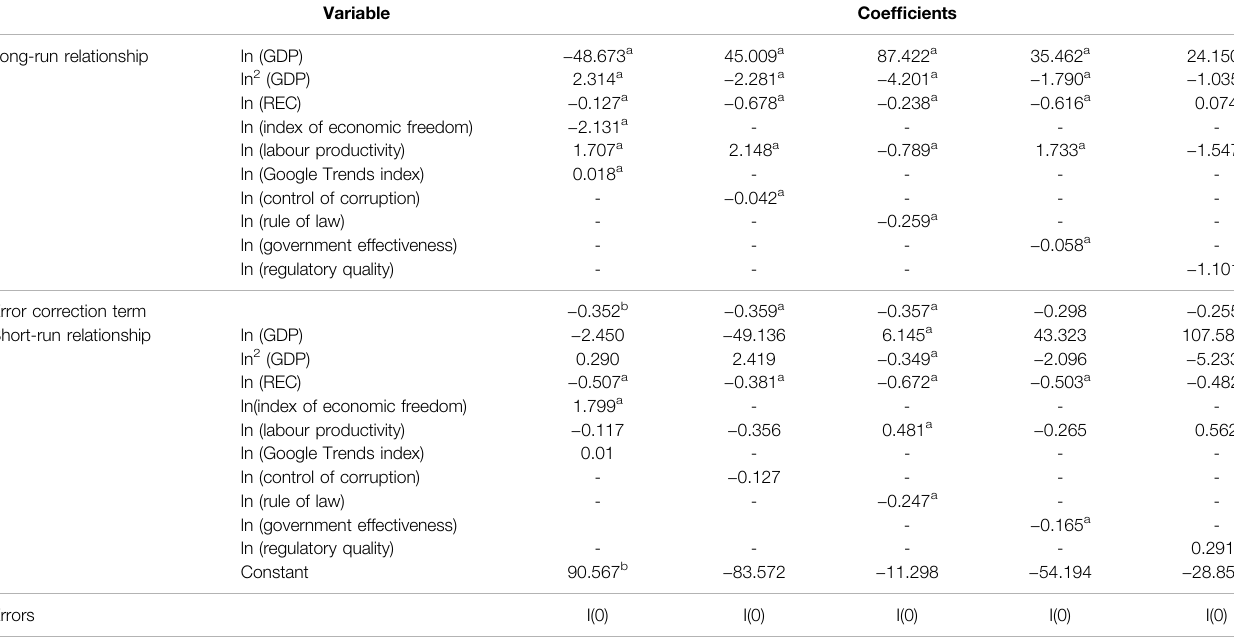
TABLE 8 | Robustness check (additional variable: labor productivity) PMG estimators to explain GHG emissions in the 10 CEE countries (2006 – 2019).